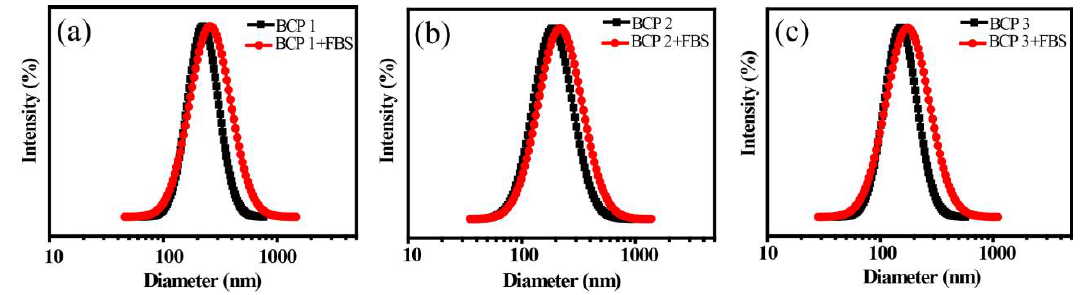
Figure 10. DLS results of micelles before and after mixing with FBS: ( a ) BCP1; ( b ) BCP2; ( c ) BCP3.